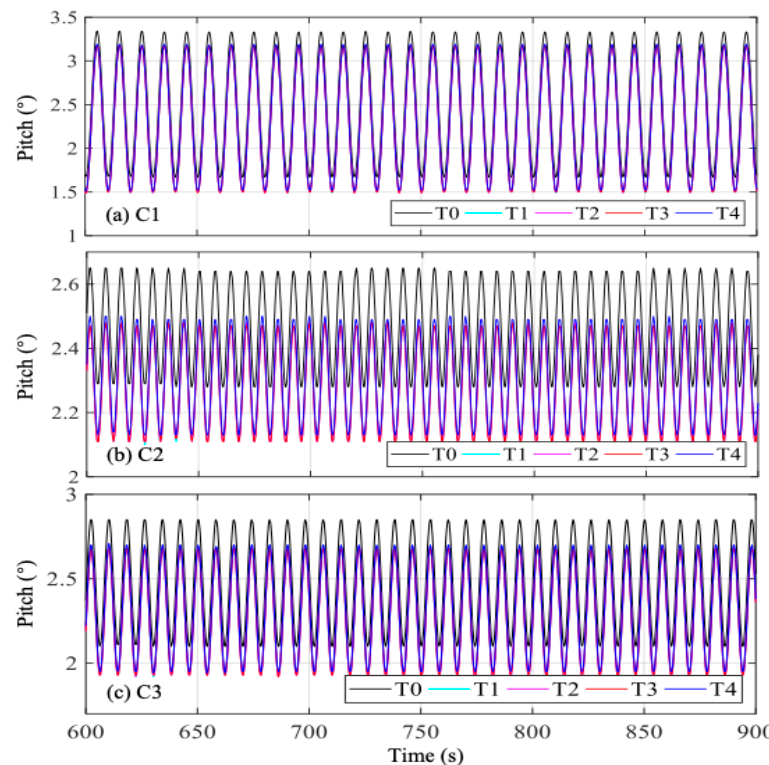
Figure 8. Wind turbine pitch movement time series in ( a ) C1, ( b ) C2, and ( c ) C3.